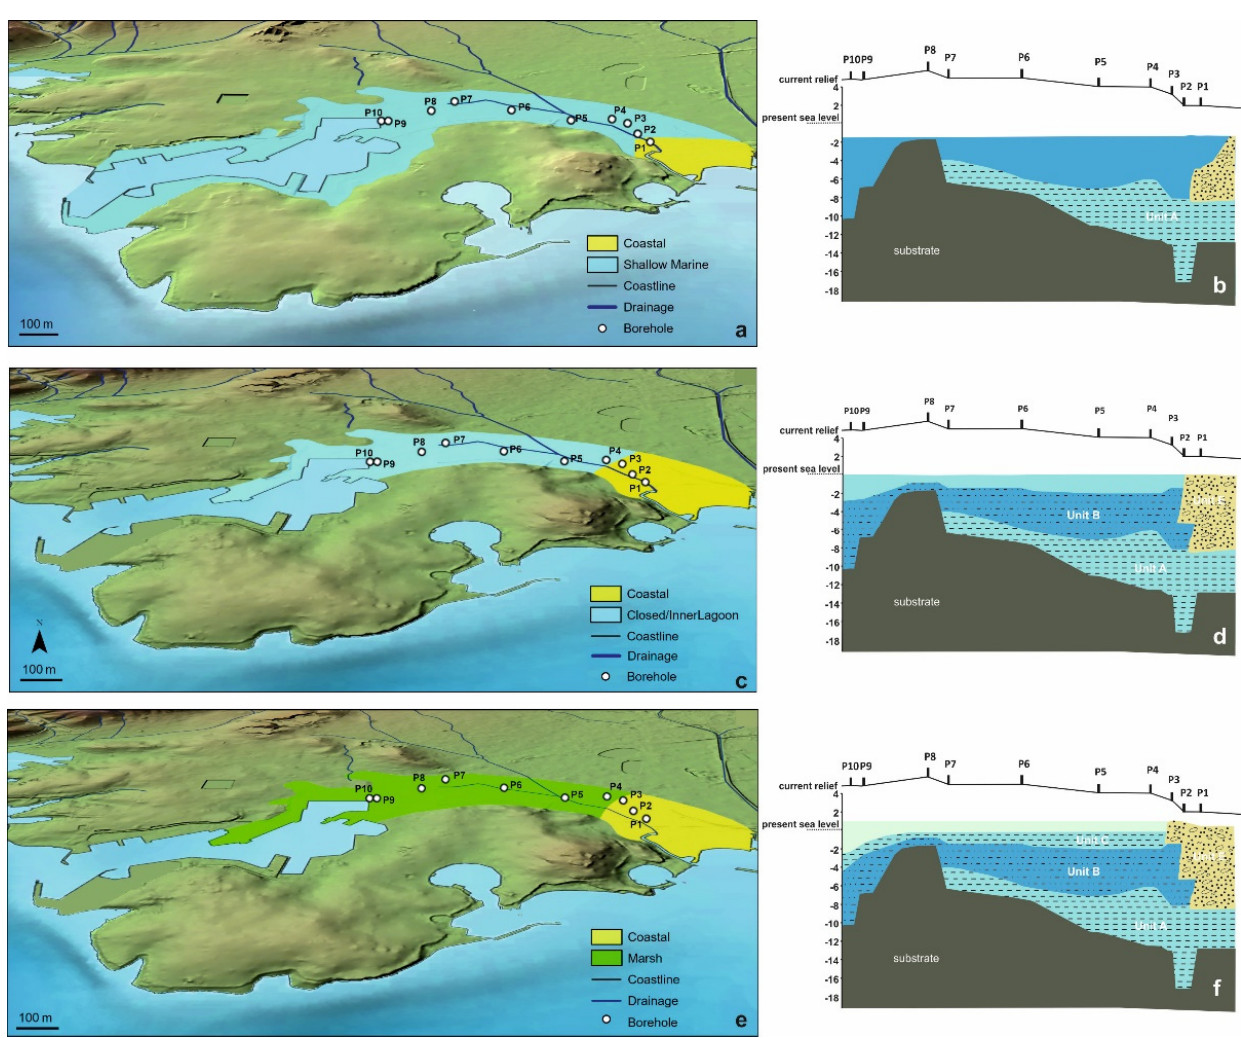
Figure 9. Paleogeographic reconstruction in respect to the present coastline and simplified sketch-transects (depths according Goiran et al. [28]), showing: ( a , b ) The Shallow Marine Bay of Piraeus (Unit B; 7500–5400 cal BP); ( c , d ) The Second Stage of the Piraeus Lagoon (Unit C; ca. 4800–3500 cal BP); ( e , f ) The Piraeus Marsh (Unit D; younger than 2800 cal BP).